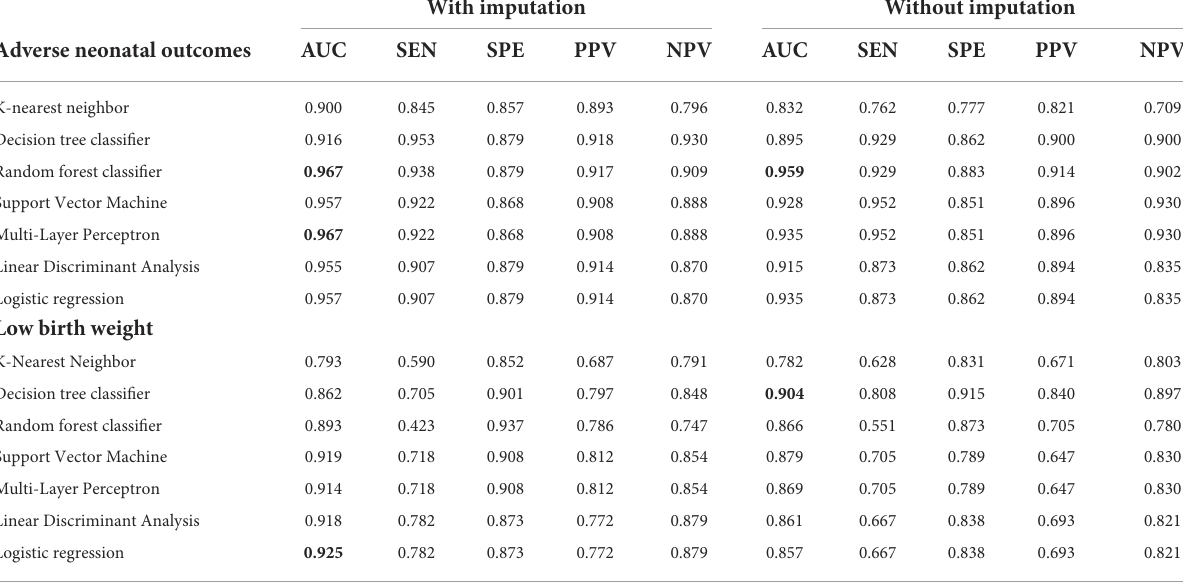
TABLE 4 The AUC, sensitivity, specificity, PPV, and NPV of different predictive models for adverse neonatal outcomes. With imputation Without imputation